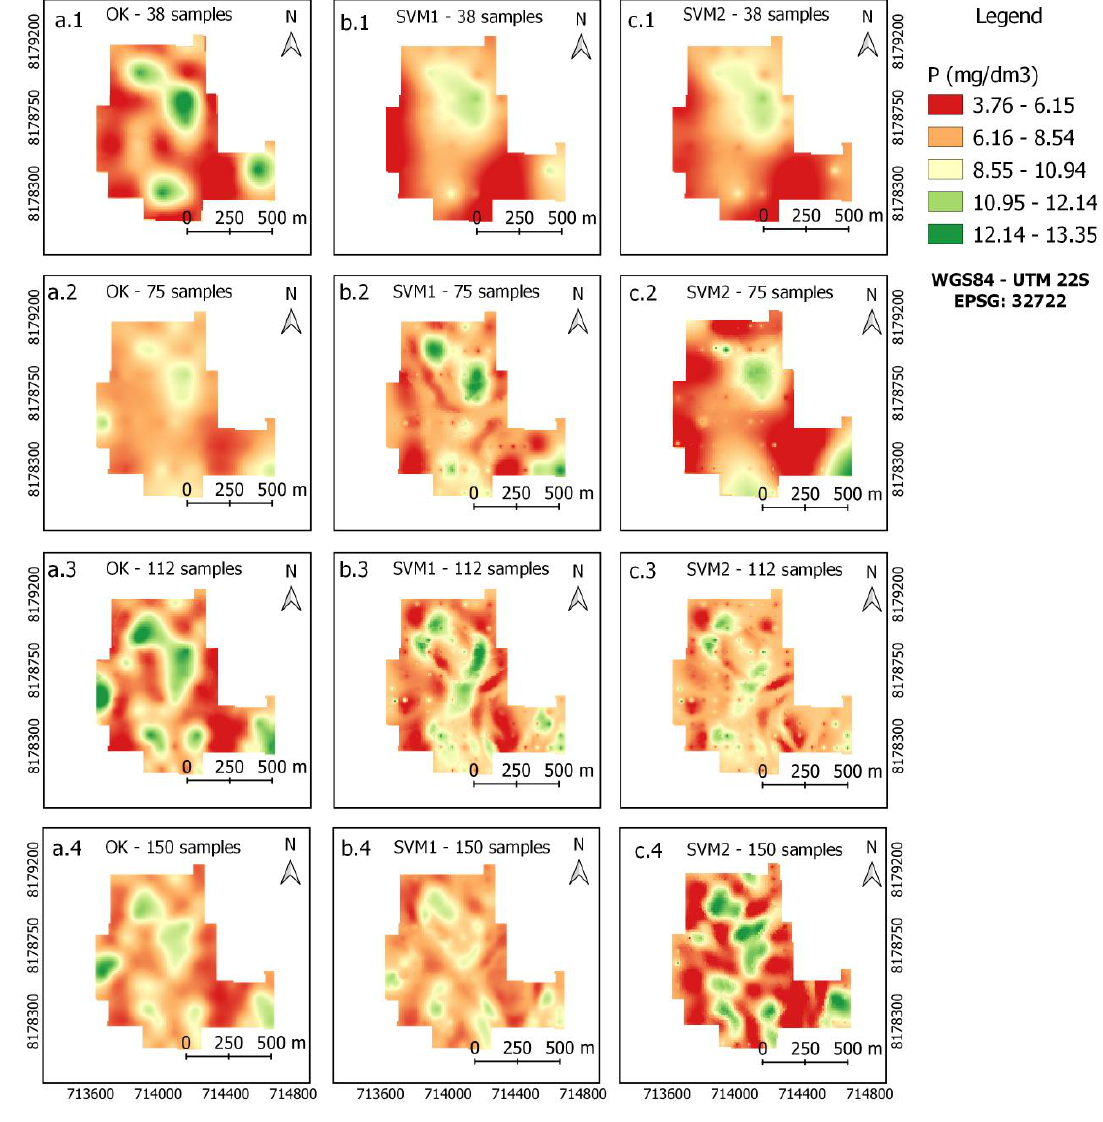
Figure 9. Maps obtained by interpolation of Phosphorus (P): ( a ) OK, ( b ) SVM1 , ( c ) SVM2 ; Set of points (training): 38 ( a.1 – c.1 ), 75 ( a.2 – c.2 ), 112 ( a.3 – c.3 ), and 150 points ( a.4 – c.4 ). For the maps obtained by interpolation of the K + attribute in grids with 38 (Figure 10(a.1 – c.1)), 75 (Figure 10(a.2 – c.2)), and 112 (Figure 10(a.3 – c.3)) samples of the training set,